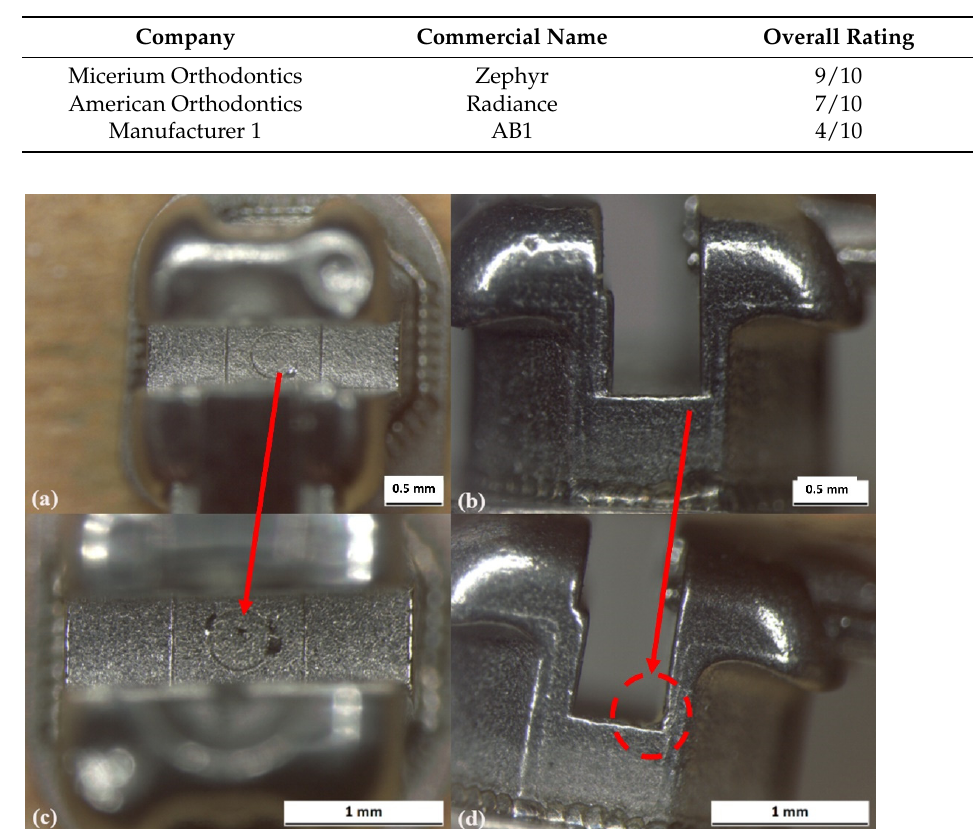
Figure 5. O-Eyes bracket (OO DENTAL) in top and side view: ( a , b ) before the test; ( c , d ) after the